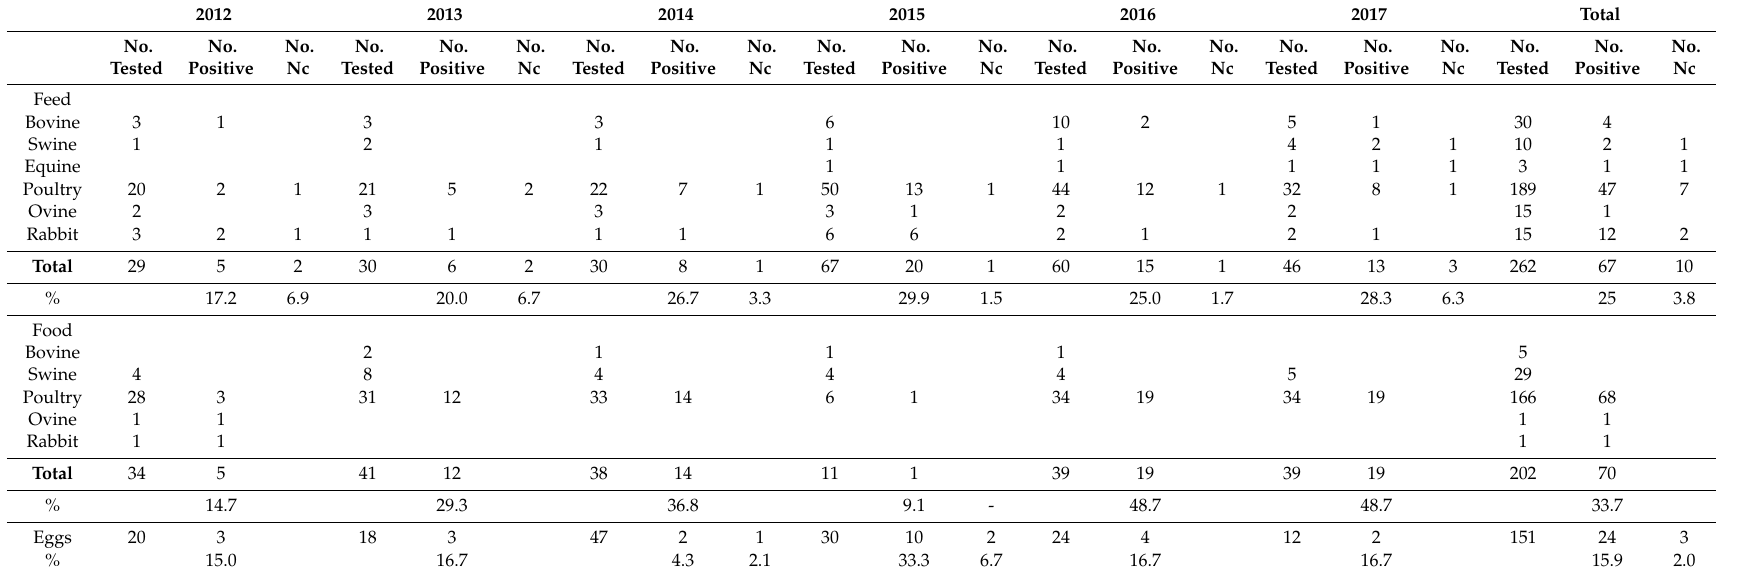
Table 2. Results for residue control of coccidiostats in central Italy during 2012–2017 in feed and food (muscle and